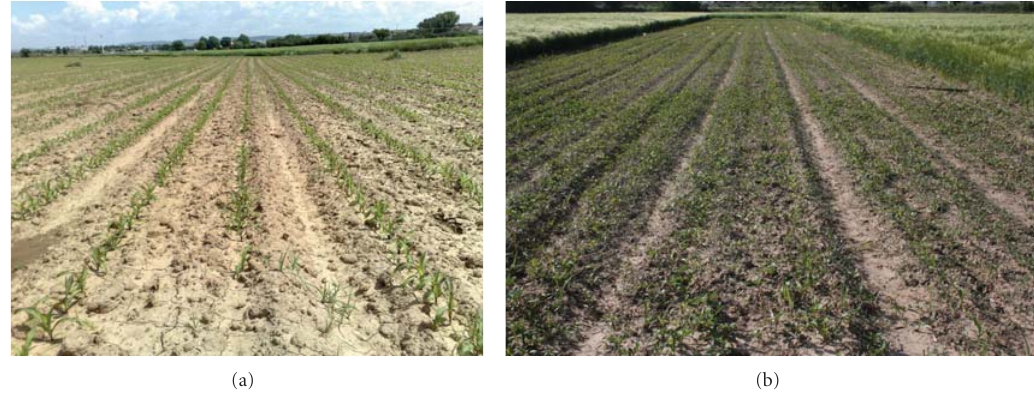
Figure 4: Di ff erent weed densities: (a) low; (b)